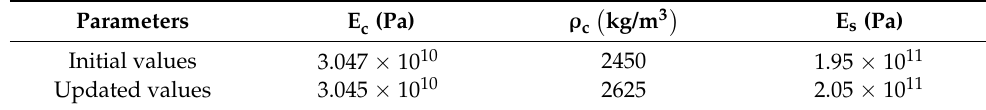
Table 8. Initial values and updated parameters of the candidate parameters.